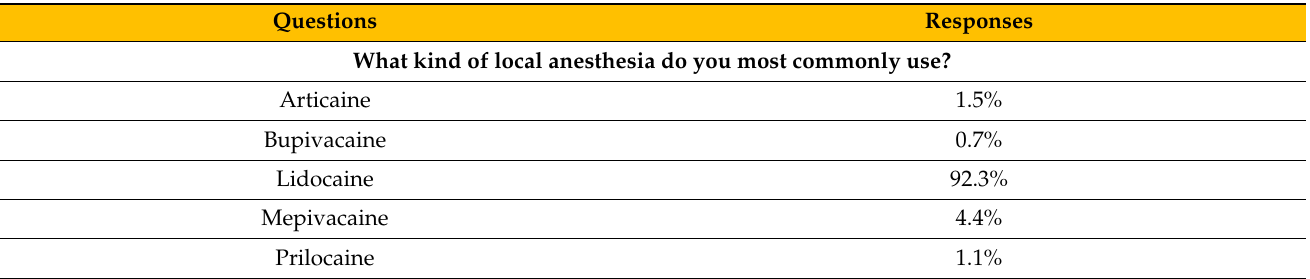
Table 1. Overall achieved scores by all the participants regarding local anesthetics used for